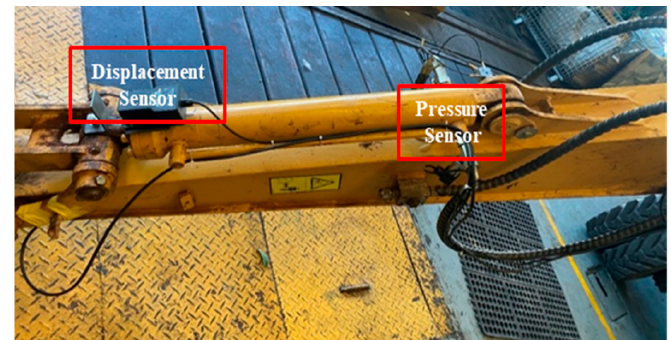
Figure 9. Installation position of cylinder displacement and pressure sensor.